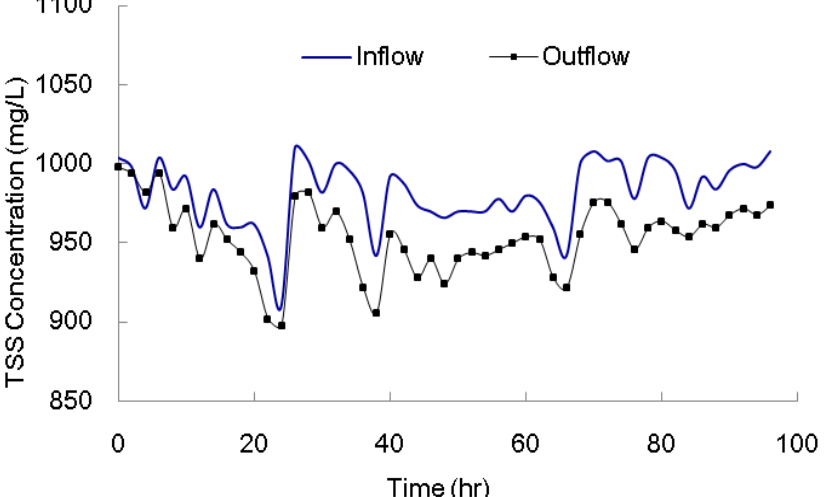
Figure 10. TSS concentration of inflow and outflow (Exp.